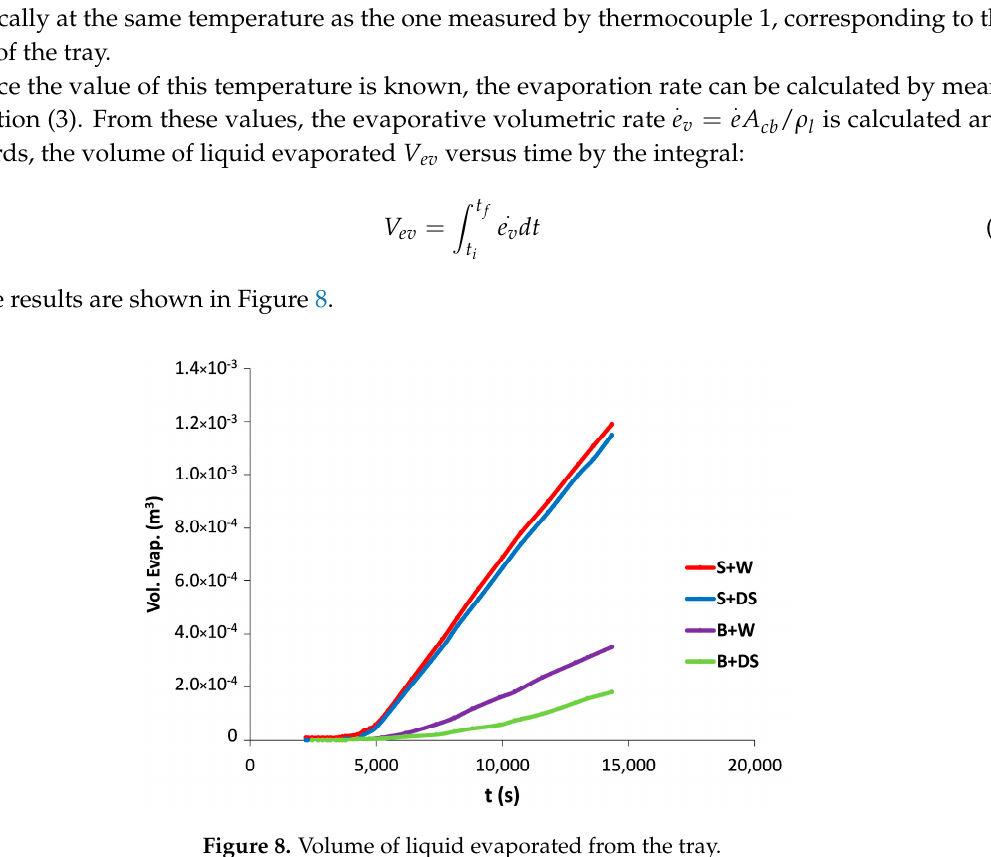
Figure 8. Volume of liquid evaporated from the tray.